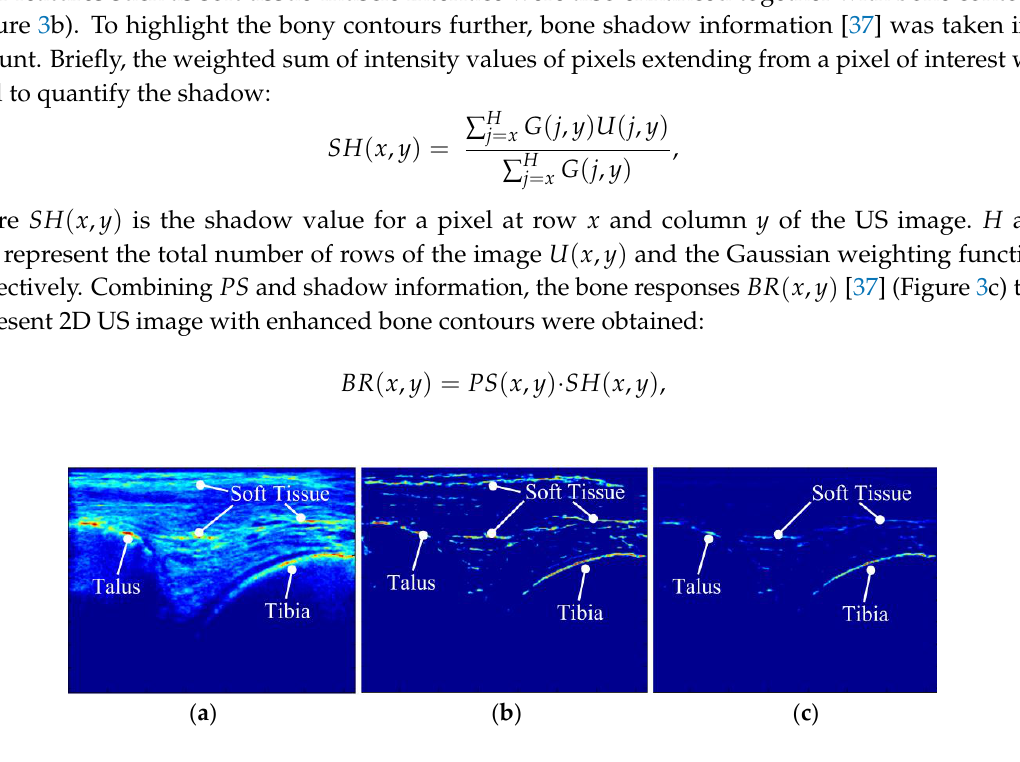
Figure 3. Bone contour enhancement in a 2D US image. ( a ) An original 2D US image ( b ) Phase Symmetry ( PS ) map calculated based on monogenic signal representation of the 2D US image. ( c ) Bone response map obtained based on the product of PS and the shadow values ( SH ).